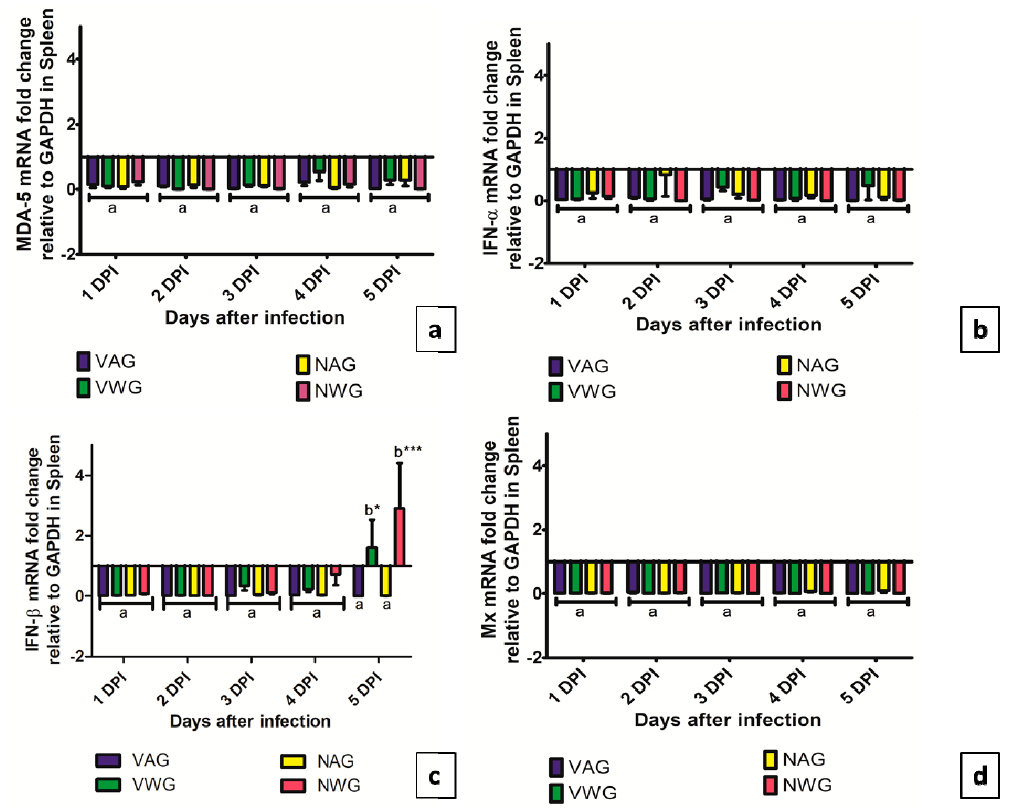
Figure 7. Expression of ( a ) MDA-5 ( b ) IFN- α ( c ) IFN- β ( d ) Mx genes in spleen of vaccinated and Non-vaccinated Aseel and White Leghorn chicken infected with very virulent IBDV. The groups were as follows: VAG-Vaccinated Aseel Group; VWG-Vaccinated WhiteLeghorn group; NAG-Non-vaccinated Aseel Group; NWG- Non-vaccinated WhiteLeghorn Group. Error bars represent standard error of the mean. Relative changes in the expression of genes were quantified by real-time PCR by comparison with expression levels of the housekeeping gene GAPDH and expressed as the fold-change. The value of 1.00 was kept as the control and the fold change values which were above the control values were considered as significant. *significant difference comparing VAG with VWG and NAG with NWG chickens of the same line at the same point where P < 0.05*, P < 0.001***. a-b: Experimental groups sharing common lowercase superscript letters are statistically non-significant for each observation